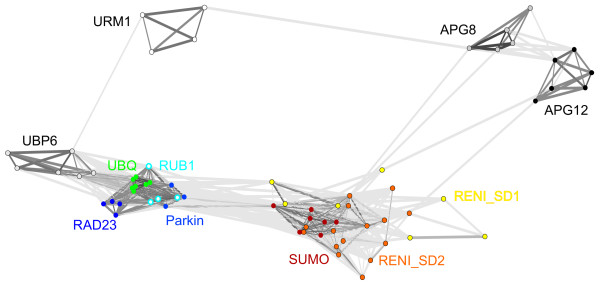
Graph representation of pair-wise sequence similarities for known ubiquitin-like domains plus SD1 and SD2 domains. SD1 and SD2 domains cluster with SUMO proteins. The graph was generated using CLANS [22] and shows all pairwise interactions based on HSP P-values calculated using all-against-all BLASTP. The sequence file used as an input is available on the homepage [11]. Analysis of a more extensive assembly of ubiquitin-fold proteins [45] leads to the same conclusion, but a less well readable graph (not shown). AGP8 – autophagy 8 like proteins, AGP12 – autophagy 12 like proteins, URM1 – ubiquitin related modifier 1, UBP6 - Ubiquitin-specific processing protease 6, RUB1 – Related to ubiquitin 1.